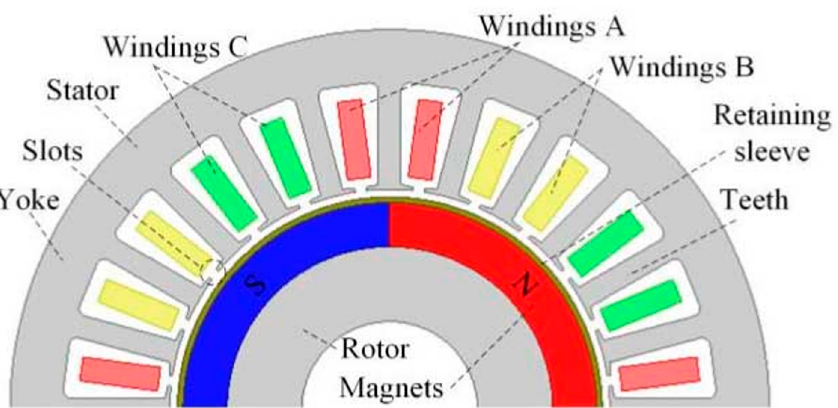
Figure 1. The structure of the high-speed PMSM. Reprinted with permission from Ref. [23]. 2021, IEEE.